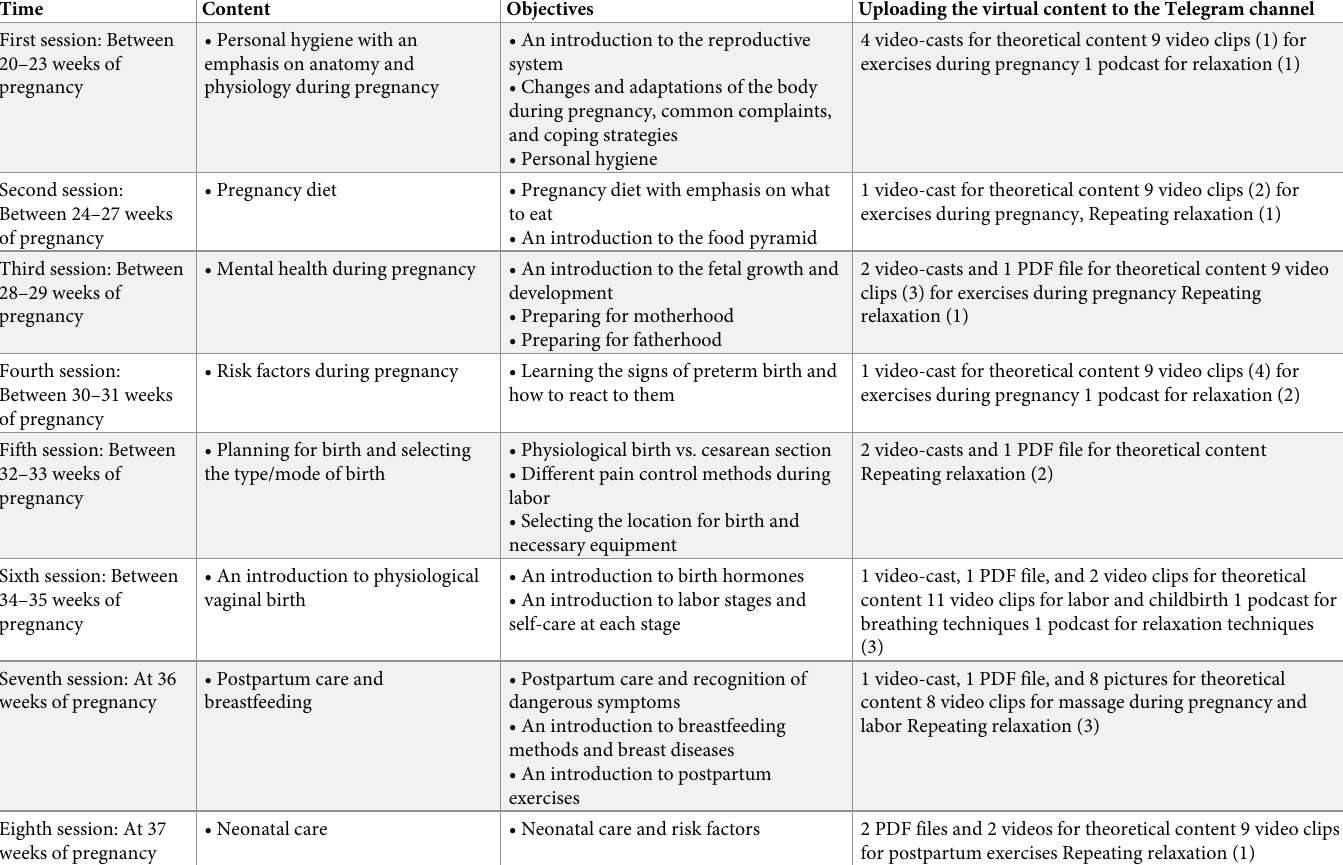
Table 1. Educational content (groups A and